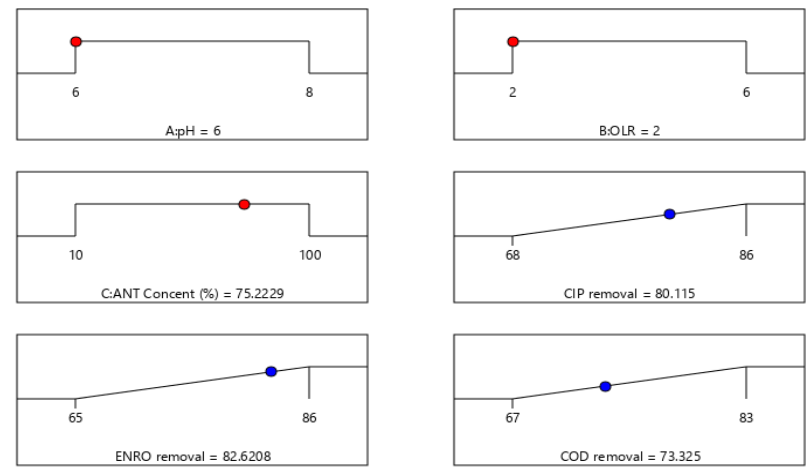
Figure 8. Ramp plot of optimum conditions and desirable responses.